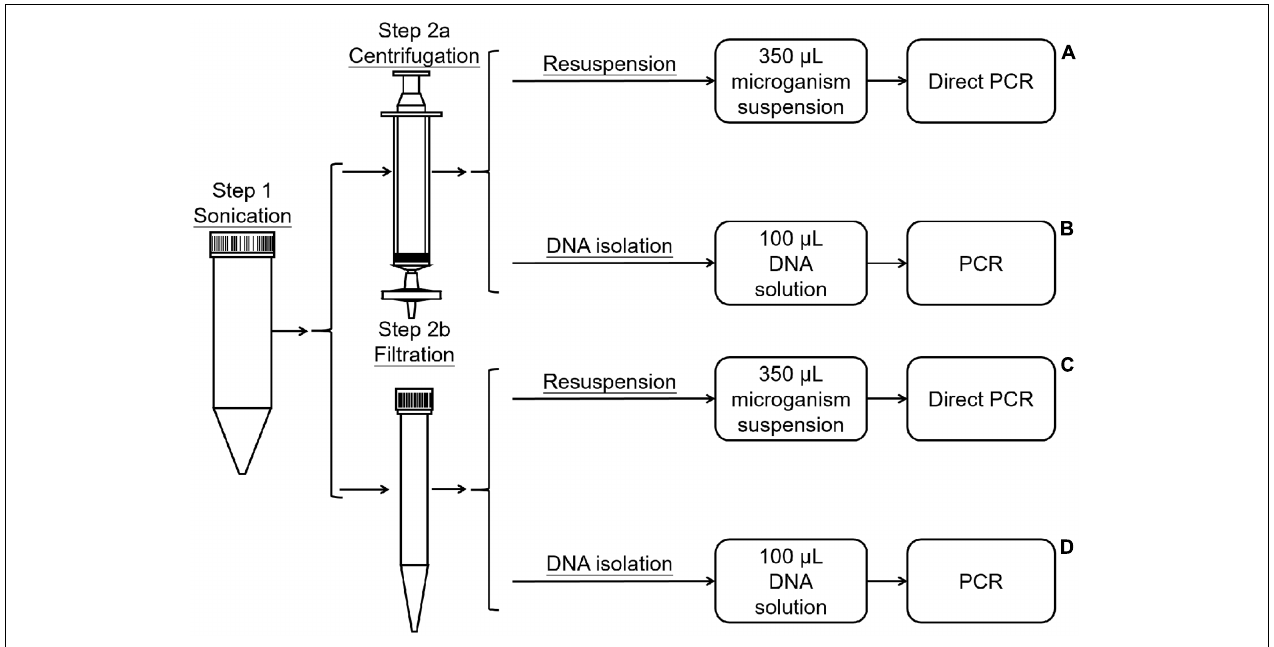
FIGURE 1 | Process of bacterial collection and DNA